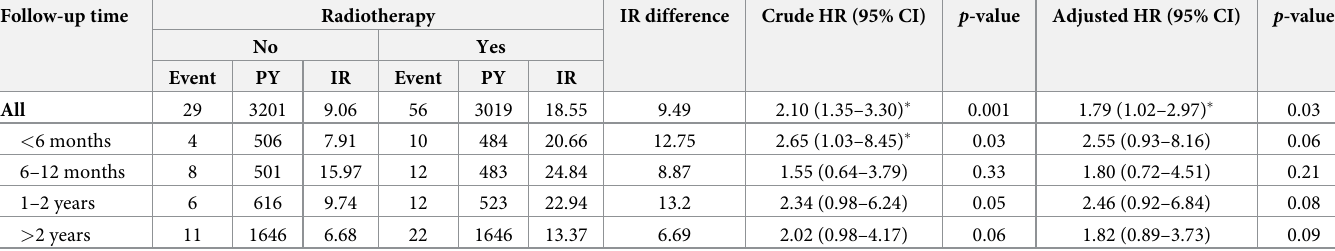
Table 4. Incidence of herpes zoster in non-RT and RT cohorts according to different follow-up periods. Follow-up